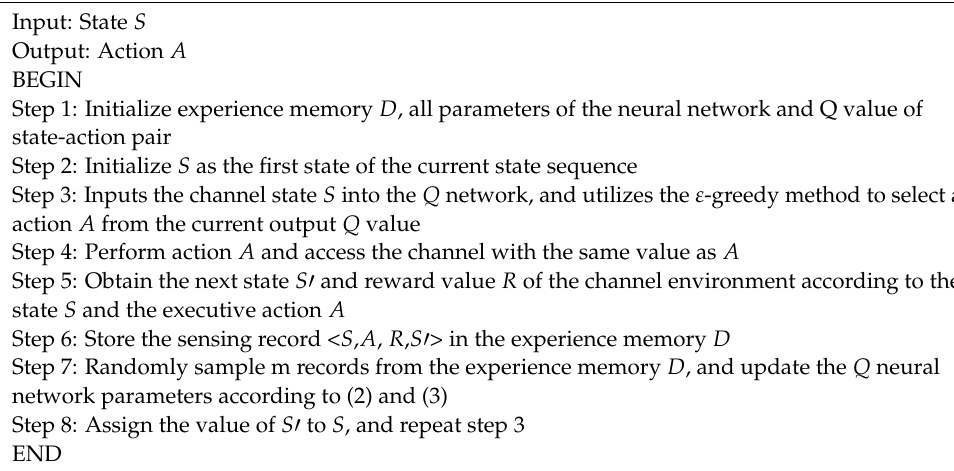
Algorithm 1 Dynamic multi-channel sensing based on DQN